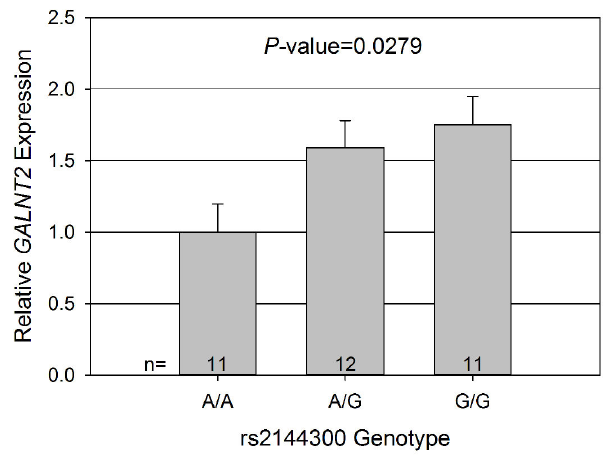
Figure 3. Plot of relative gene expression of GALNT2 by rs2144300 genotype. Gene expression analysis performed in 34 PEAR whites, normalized to β-2-microglobulin. Error bars represent standard error.